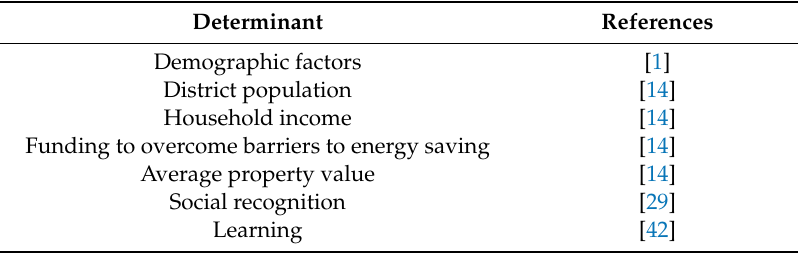
Table 4. Sociodemographic and economic determinants in